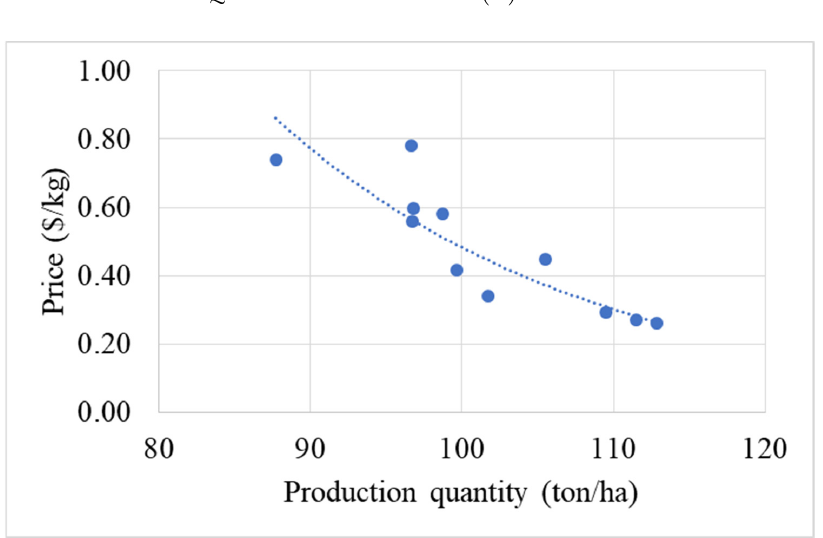
Figure 5. Price curve under different production quantities of Chinese cabbage in South Korea.